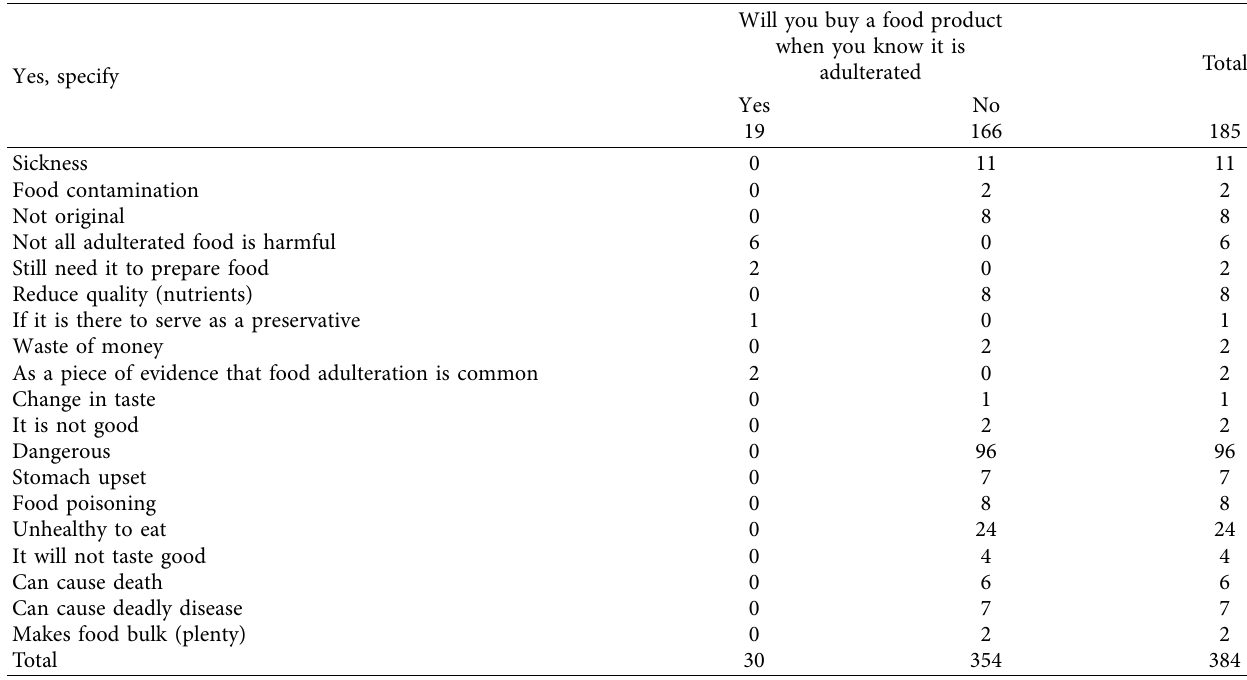
Table 4: Respondents’ reasons for buying or not buying an adulterated food product.